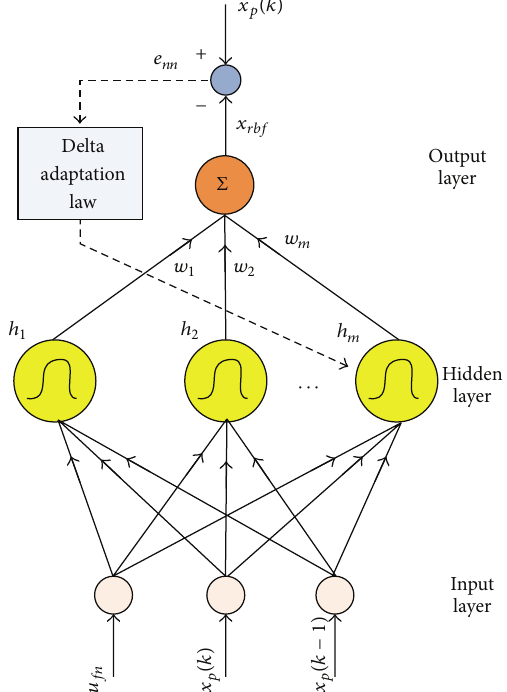
Figure 11: The architecture of